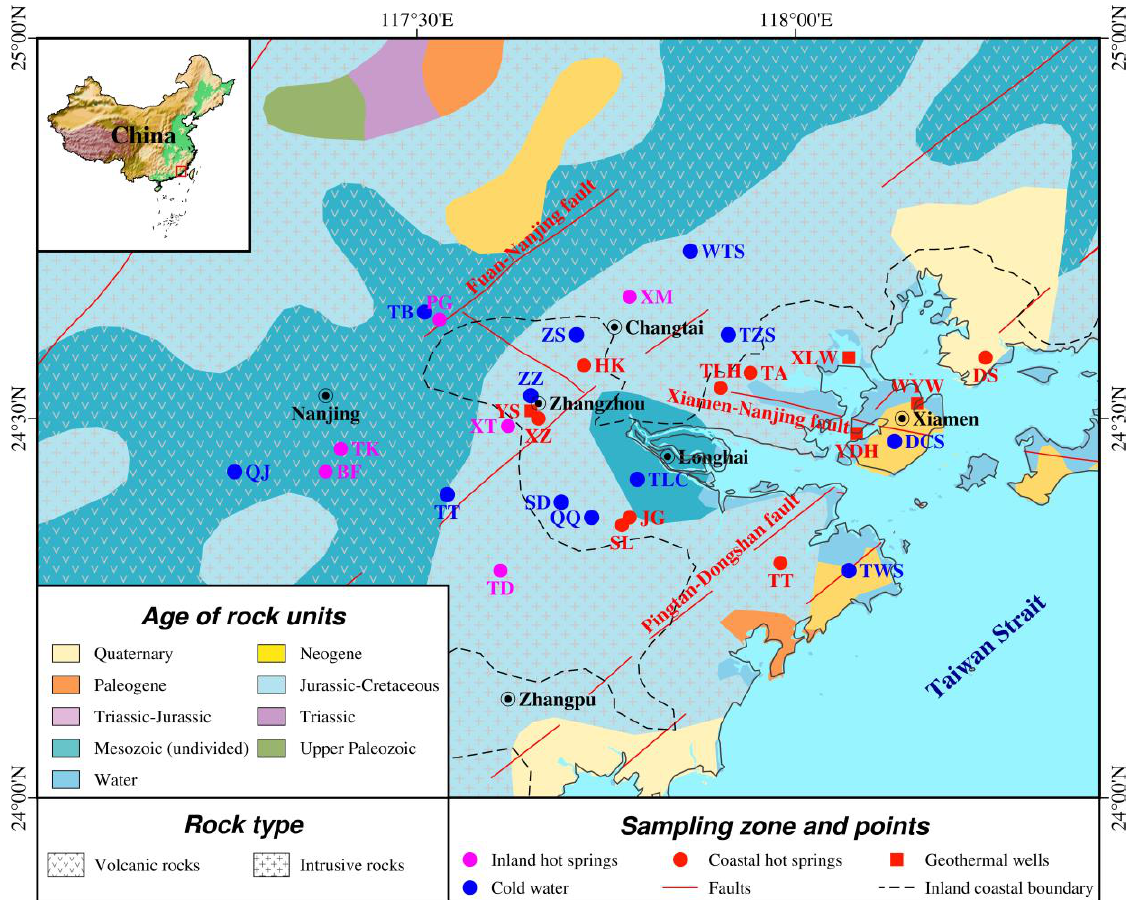
Figure 1. Geological map of the study area and the distribution of sampling points.